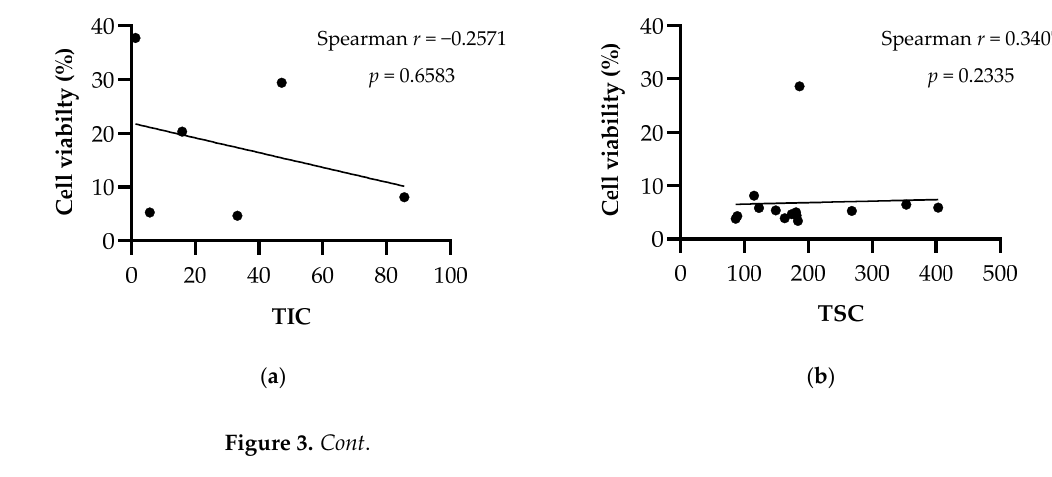
Figure 2. Spearman’s correlation between cytotoxic effects of extracts against MCF-7 cells and their phytochemical content. ( a ) TIC: Total iridoid content (mg aucubin equivalents/g extract). ( b ) TSC: Total sterol content (mg cholesterol equivalents/g extract). ( c ) TTC: Total triterpenoid content (mg oleanolic acid equivalents/g extract). ( d ) Ursolic acid (mg/g extract).